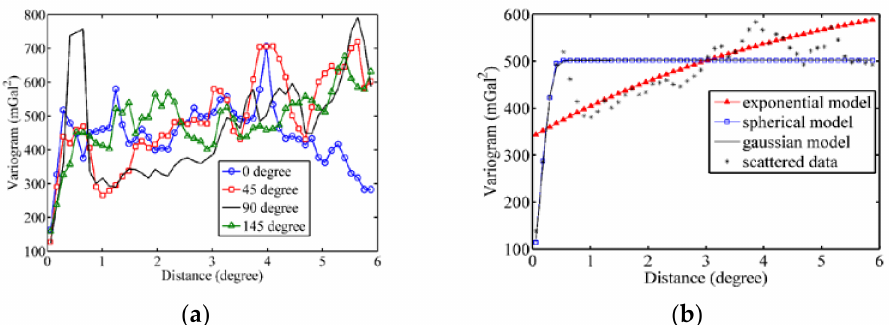
Figure 3. Analysis results of spatial variability analysis. ( a ) Experimental variograms in different directions. ( b ) The results of variogram